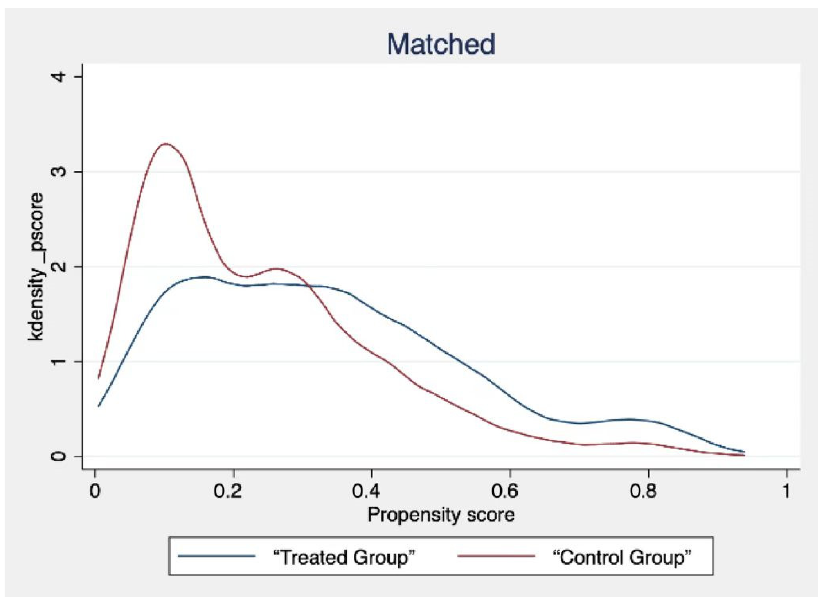
Figure 4. Kernel density function after matching.